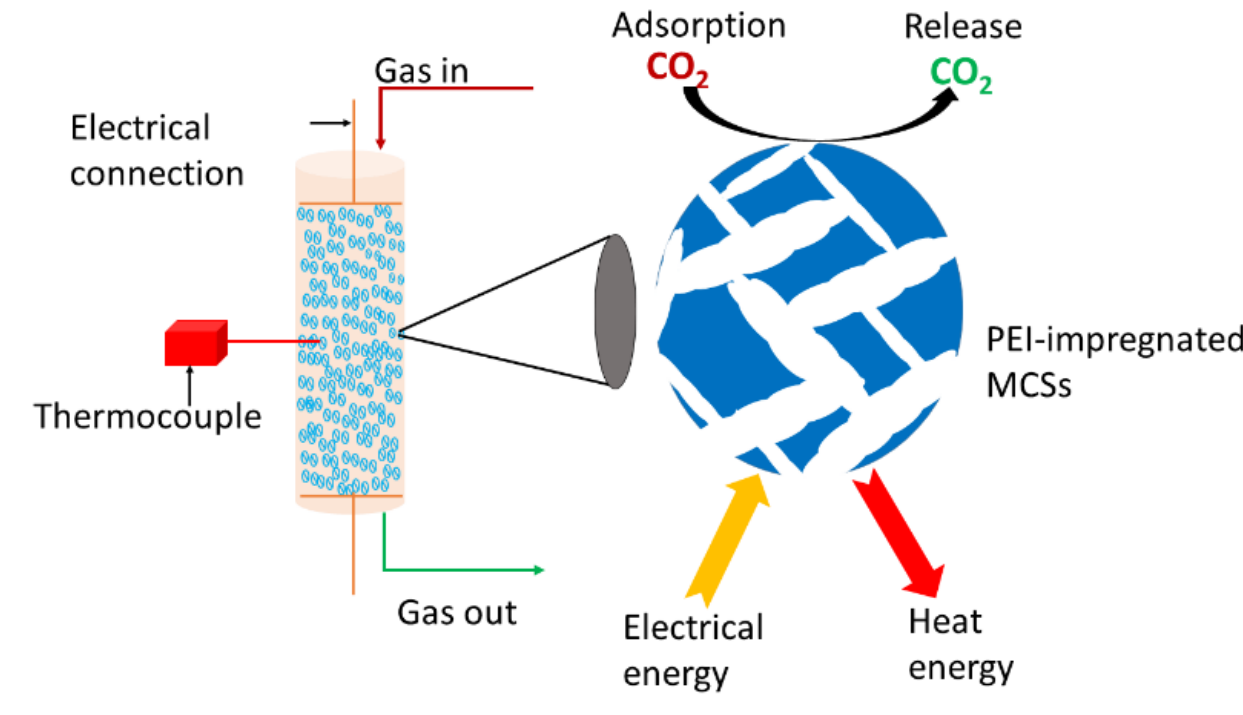
Figure 3. Schematic representation of the adsorption column for electric swing adsorption (Reprinted with permission from ref. [108]).